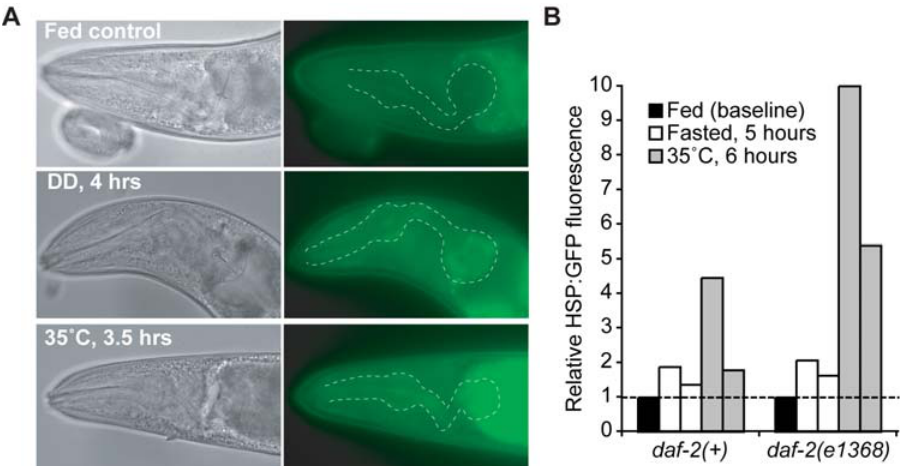
Figure 3. Nutrient stress did not strongly induce hsp-16.2:GFPreporter expression. A GFP reporter expressed from the hsp16.2 promoter was examined in animals under food-replete, fasted and heat-stressed conditions. (A) Under food-replete conditions (fed), fluorescence from hsp16.2: GFP was undetectable in the pharynx region of most animals. After a 4 hour fasting regimen, elevated hsp-16.2: GFP fluorescence was observed in many animals, as it was for animals under thermal stress (35˚C, 3.5–6 hours). (B) Relative GFP fluorescence in the pharynx region of animals carrying the hsp- 16.2:GFP reporter. Fluorescence intensity was measured as average pixel intensity in same-sized regions of the pharynx. Fluorescence intensity measurements under food-replete conditions were set as baseline. Duplicate bars indicate results from two independent experiments; n=14–19 animals scored per condition in each experiment. In both experiments, 35˚C heat stress induced a statistically significant increase in hsp-16.2 :GFP fluorescence intensity (p # 0.001 compared to fed controls). Nutrient stress was not correlated with reproducible statistically significant changes in hsp-16.2 :GFP fluorescence intensity (p # 0.001 in one trial only). All conditions were tested on the same day and images were collected using identical acquisition parameters. Three additional experiments also gave similar